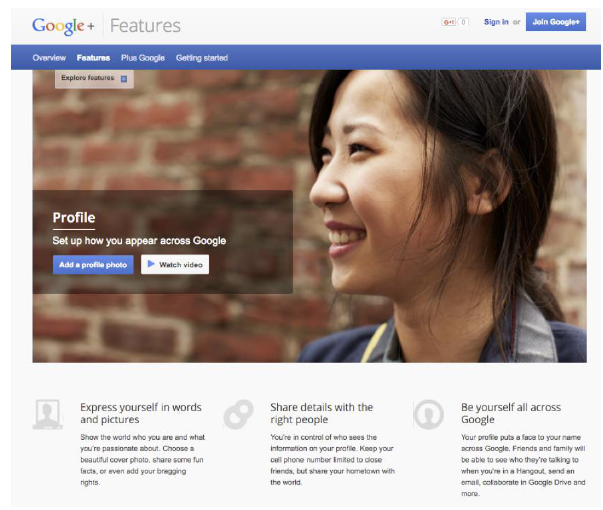
Figure 1. A screenshot from the Google+ feature tour, 1 August 2013 [52].